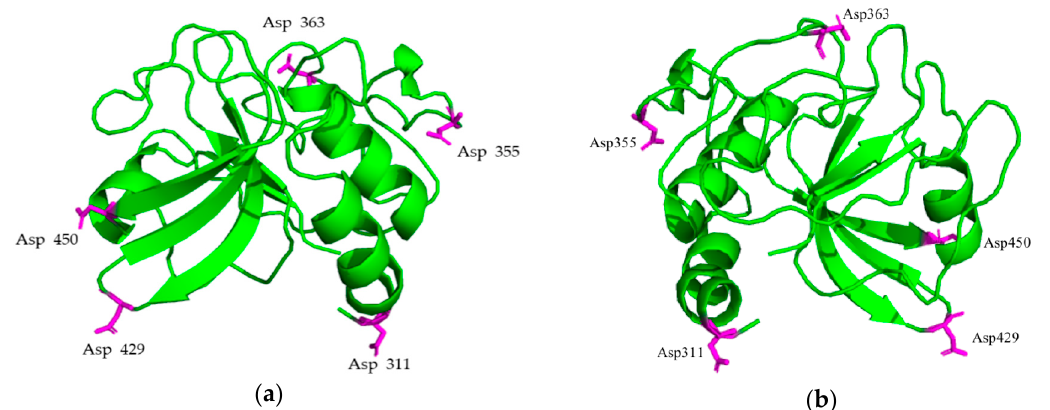
Figure 1. Mutation sites of PlyC CHAP. ( a ) 3.3 Å resolution of the PlyC CHAP crystal structure. The magenta-colored amino acids represent the potential mutation sites. ( b ) 180° horizontal rotation of (a). The mutation sites are solvent exposed, not structured in α -helix or β -sheets, and form no interactions with other residues.